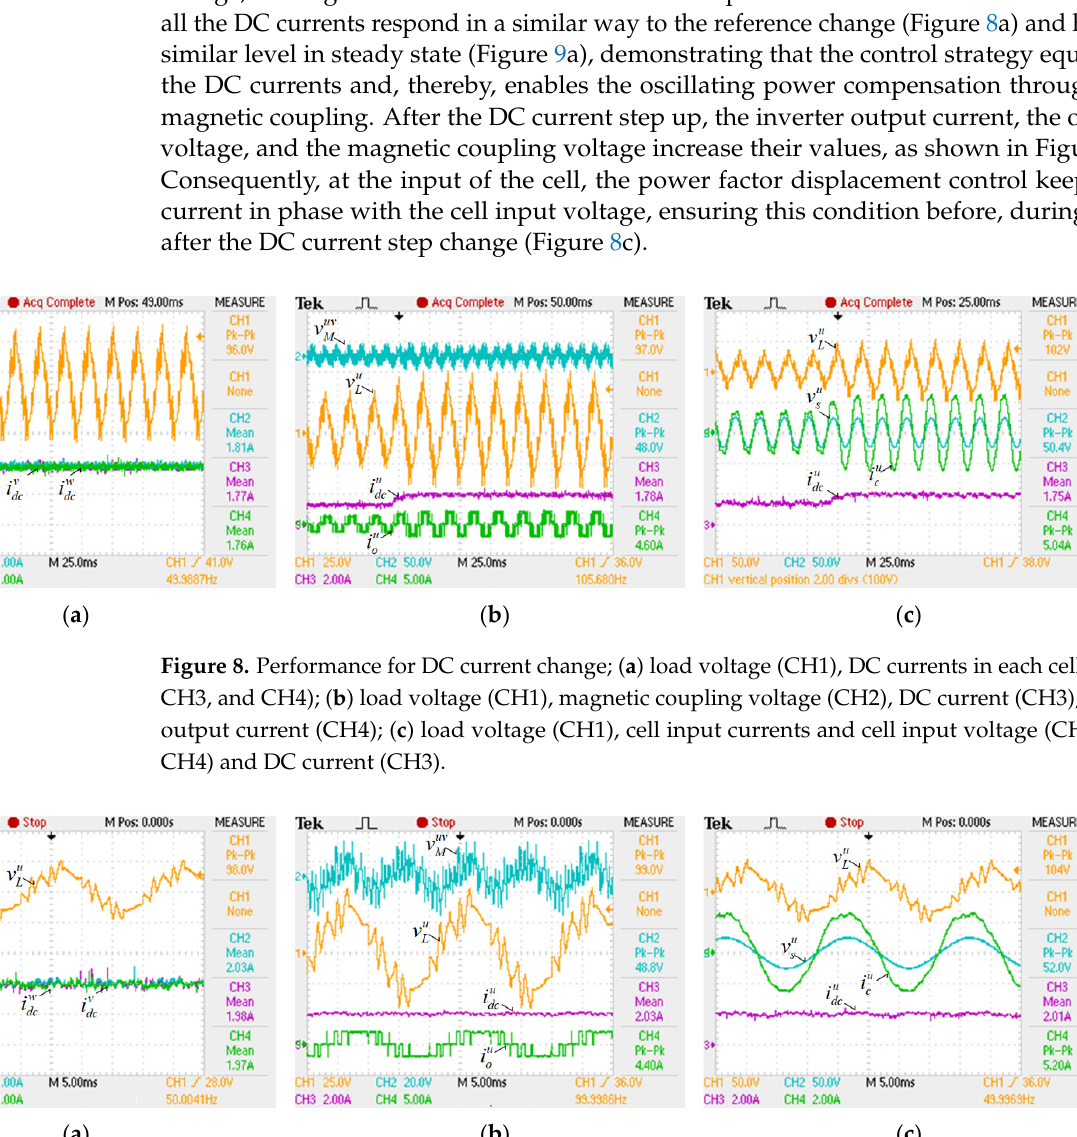
Figure 9. Performance for steady state: ( a ) load voltage (CH1, THD = 30.2%), DC currents in each cell (CH2, THD = 4.3%, CH3, THD = 4.1% and CH4, THD = 4.2%); ( b ) load voltage (CH1, THD = 30.2%), magnetic coupling voltage (CH2, THD = 12.4%), DC current (CH3, THD = 4.1%), PWM output current (CH4, THD = 46.2%); ( c ) load voltage (CH1, THD = 30.2%), cell input voltage and cell input current (CH2, THD = 2.2% and CH4, THD = 6.7%), and DC current (CH3, THD = 4.3%).